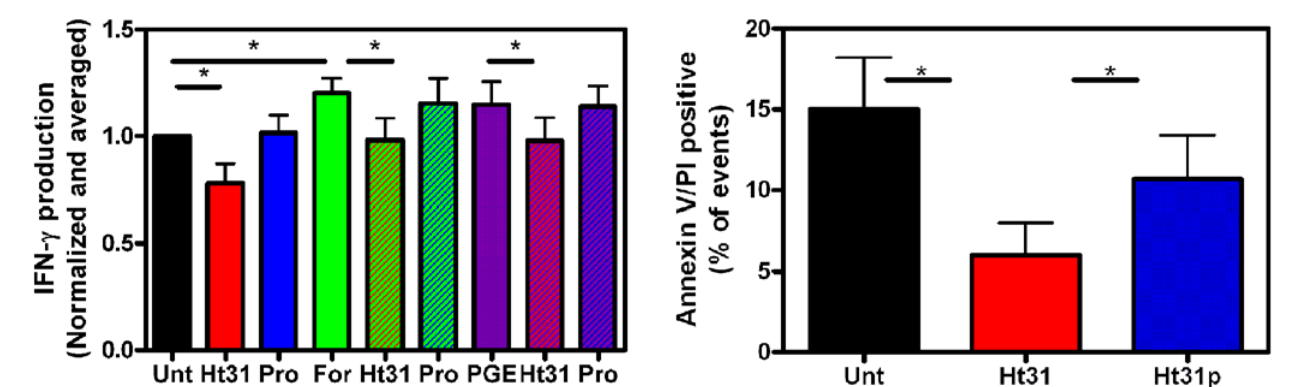
Figure 6. Ht31 is not inducing cell death. Day 5 DC were incubated without (Unt, black bars) or with 100 m M Ht31 (red bars) or Ht31p (blue bars) for 48 hours, collected, stained with annexin V and propidium iodide and analyzed by FACS. Percent annexin V/PI positive events from three different donors were averaged. Error bars are S.E.M. Student ttest reveals significance, P , 0.05(*). cells are indicated by the red trace, and Ht31p treated cells are shown as the blue trace. In C, LPS treated cells are illustrated by the orange trace, LPS with Ht31 are red and LPS with Ht31p are